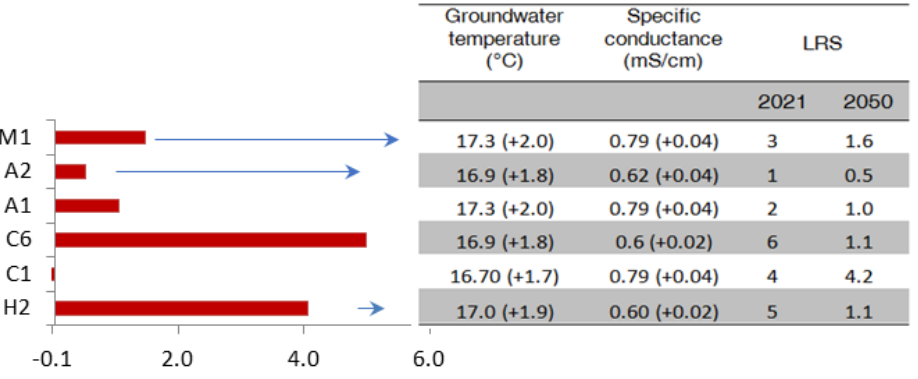
Figure 8. Prediction of 2021 reductions for 2050 in stygofauna taxa resilience in Murgia and Salento groundwaters because of climate change, leading to groundwater temperature and specific con- ductance increases of up to 2 °C and 0.04 mS/cm.